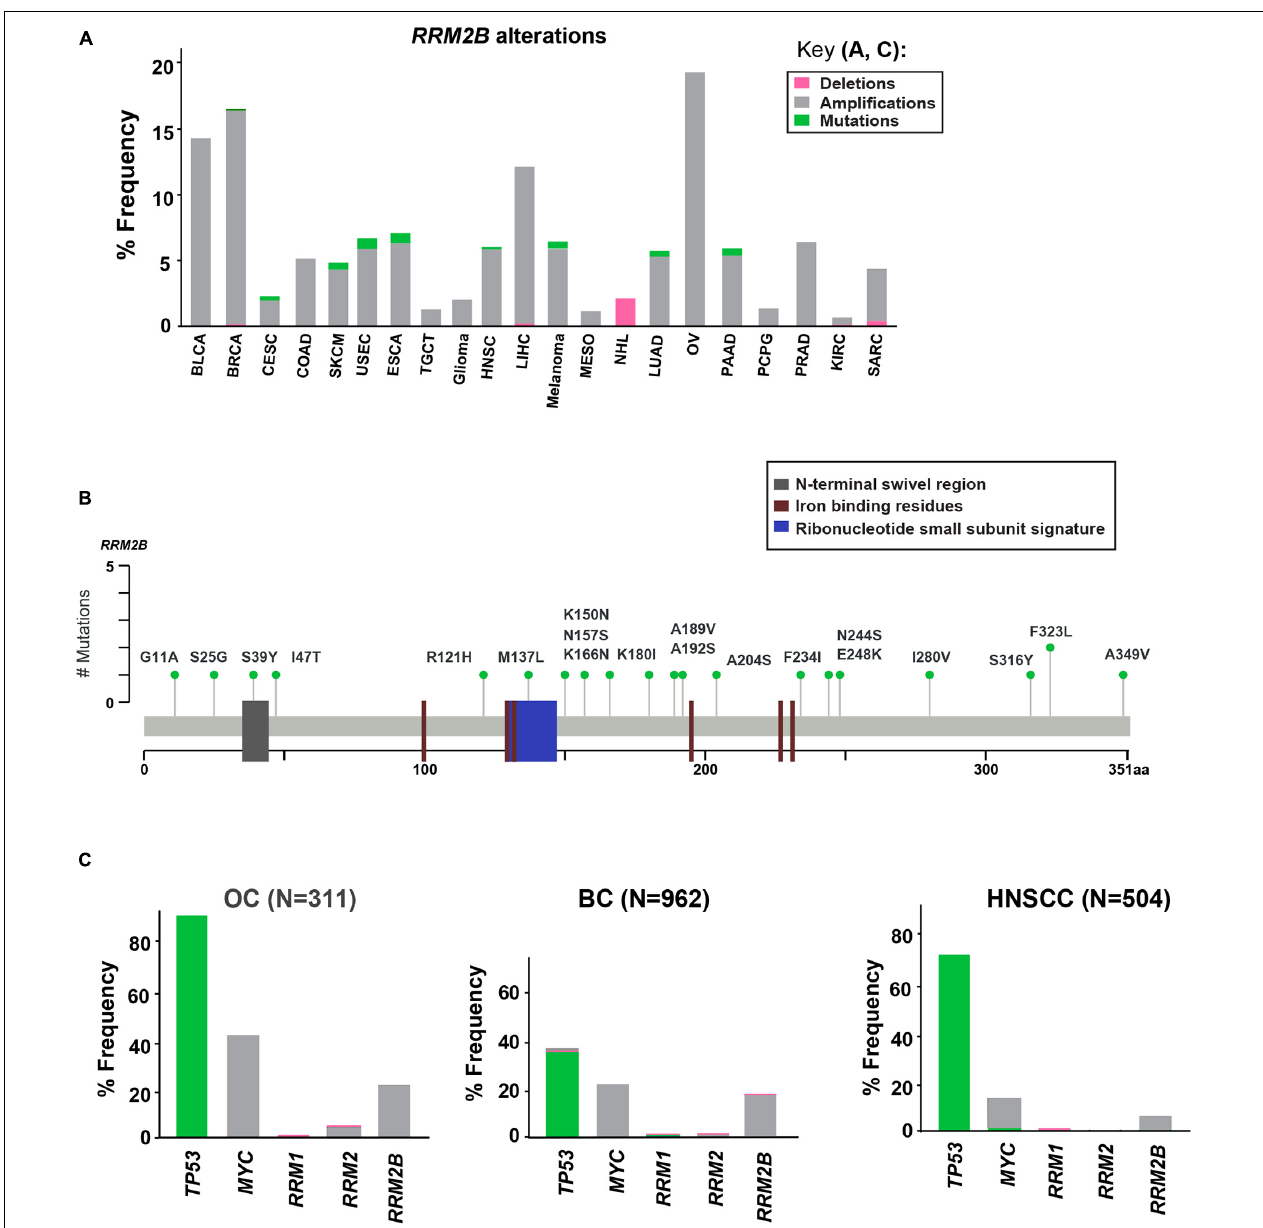
FIGURE 1 | Somatic alterations in RRM2B from cbioportal.org. (A) Somatic alterations in RRM2B across TCGA studies. BLCA, Bladder urothelial carcinoma; BRCA, Breast invasive carcinoma; CESC, Cervical squamous cell carcinoma and endocervical adenocarcinoma; COAD, Colon adenocarcinoma; SKCM, Skin cutaneous melanoma; USEC, Uterine corpus endometrial carcinoma; ESCA, Esophageal carcinoma; TGCT, Testicular germ cell tumors; HNSC, Head and neck squamous cell carcinoma; LIHC, Liver hepatocellular carcinoma; MESO, Mesothelioma; NHL, Non-Hodgkin lymphoma; LUAD, Lung adenocarcinoma; OV, Ovarian serous cystadenocarcinoma; PAAD, Pancreatic adenocarcinoma; PCPG, Pheochromocytoma and paraganglioma; PRAD, Prostate adenocarcinoma; KIRC, Kidney renal clear cell carcinoma; SARC, Sarcoma. Amplifications (gray), mutations (green), and deletions (pink) are represented as percent frequency. (B) RRM2B mutations in TCGA. 2D RRM2B protein stick figure showing the important domains of RRM2B [N-terminal swivel region, required for dimer stability, gray; ribonucleotide small subunit signature (conserved region in catalytic site between RRM2 and RRM2B), blue, and iron-binding residues required for catalytic activity, red] and the number of somatic mutations in RRM2B. (C) Frequency of TP53 , MYC , RRM1 , RRM2 and RRM2B alterations in ovarian (OC), breast (BC), and head and neck (HNSCC)